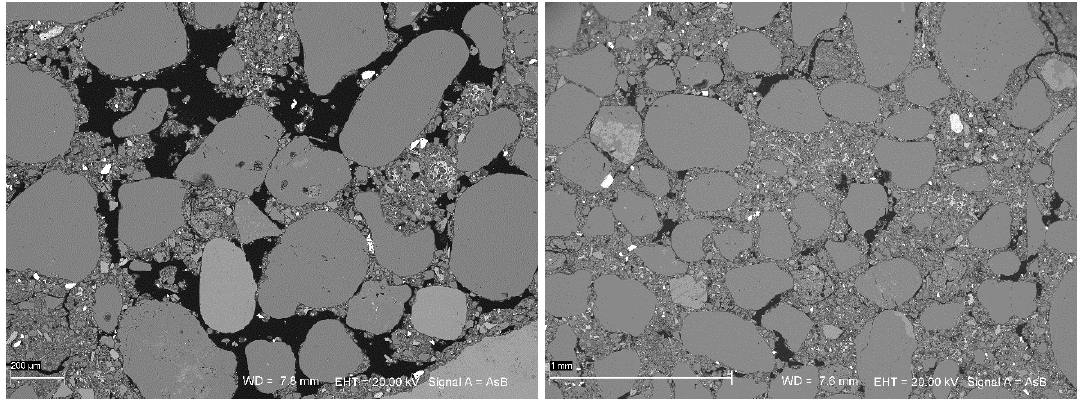
Figure 15. SEM images of samples LC XI 6% CEM (left) and LC XI 9% CEM (right).